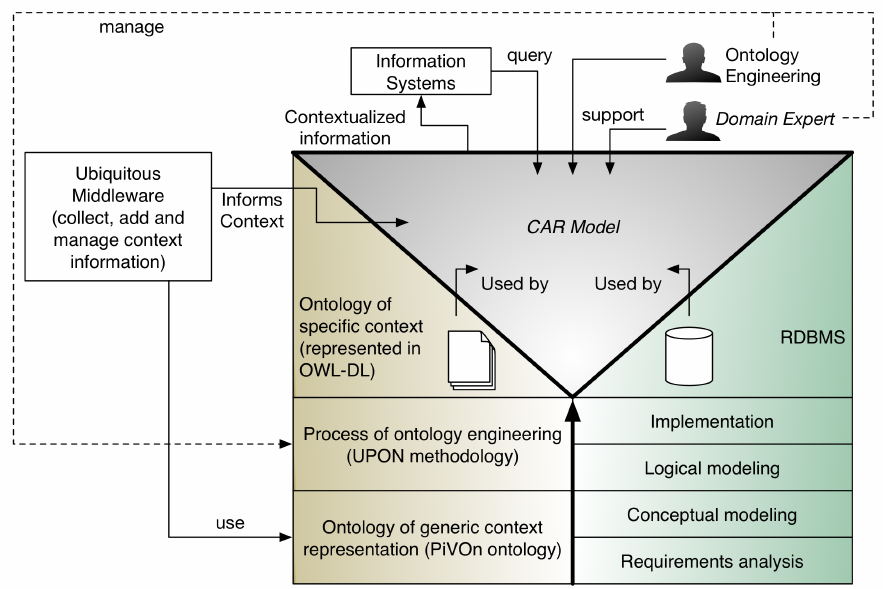
Figure 3. Overview of a scenario of recommendation of resources in a smart university